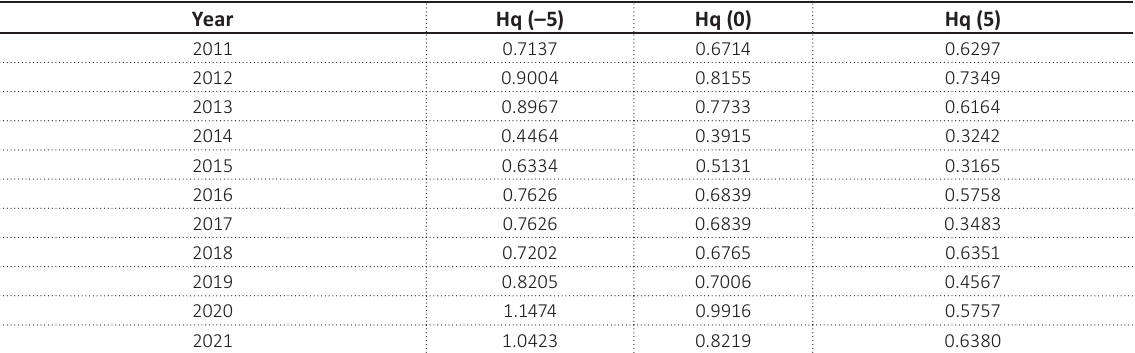
Table 2. Illustrating the results of Hurst for BSE 100